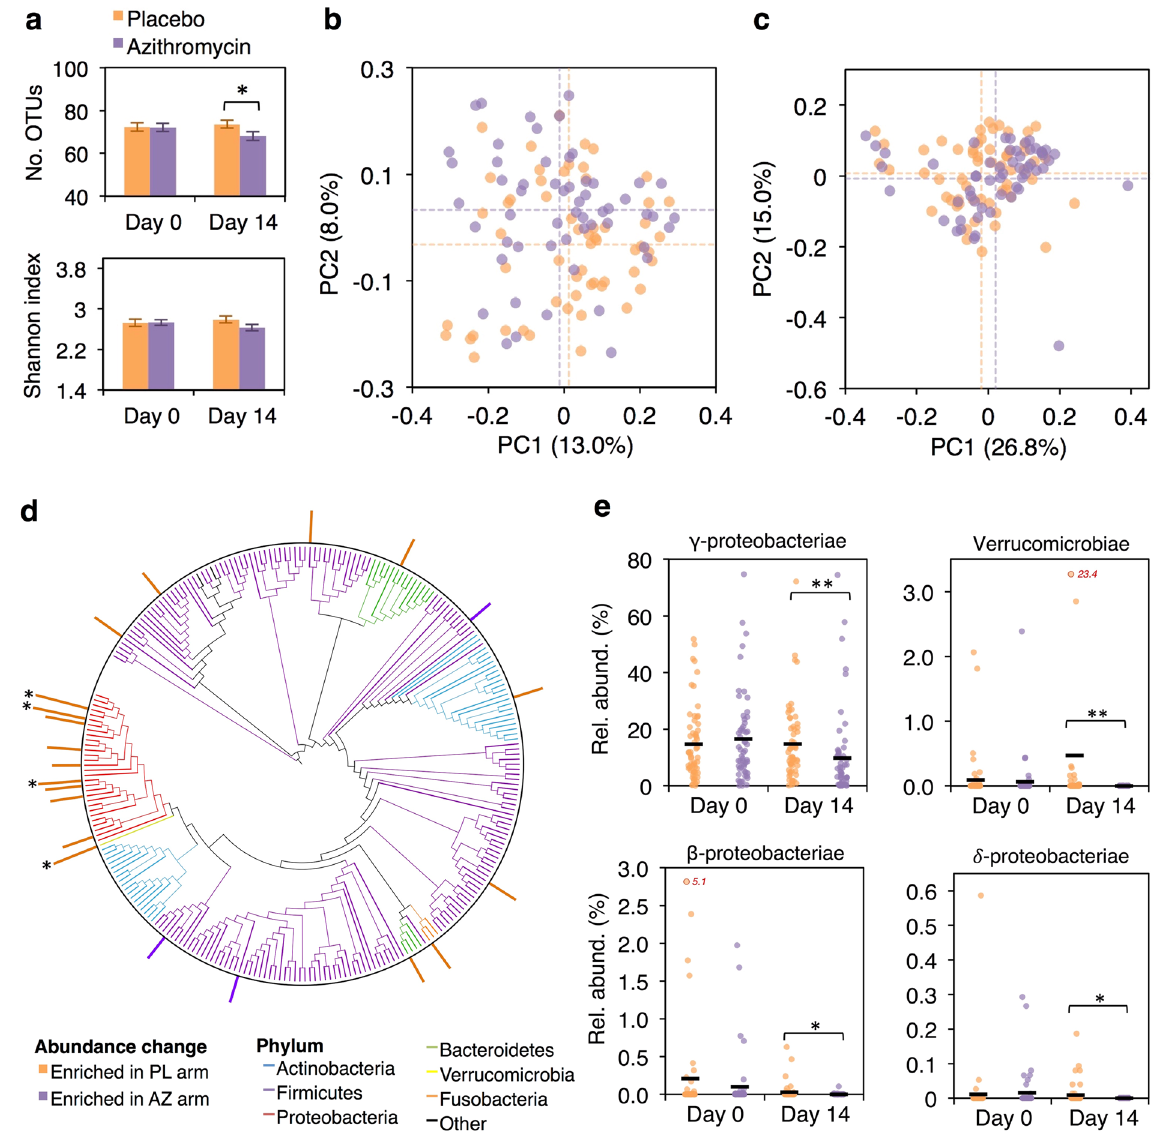
Figure 2. Impact of azithromycin on the bacterial microbiota. ( a ) OTU count and Shannon index (mean ± standard error) according to study arm. ( b ) Unweighted and ( c ) weighted Unifrac distances between day-14 infant samples, visualised via principal coordinates analysis. Mean values for each principal coordinate are indicated by dotted lines. ( d ) OTU-level differences in relative taxon abundance at day 14 according to study arm. Bars display p values on a negative log 10 scale. Comparisons with a p value of < 0.05 prior to FDR correction are indicated. The tree was constructed from de novo OTU sequences spanning the V4 region of the 16S rRNA gene. Owing to the use of a relatively short (and hypervariable) segment of the 16S rRNA gene for tree construction, phyla do not always separate into discrete lineages. ( e ) Class-level differences in taxon abundance according to study arm. Mean relative abundance values for each study arm are indicated by horizontal lines. Values beyond the scale of the y-axis are indicated in red. * P < 0.05 (after FDR correction for abundance comparisons); ** FDR-corrected P < 0.005. Abbreviations: AZ, azithromycin; OTU, 97%-identity operational taxonomic unit; Rel. abund., relative abundance; PC, principal coordinate; PL,